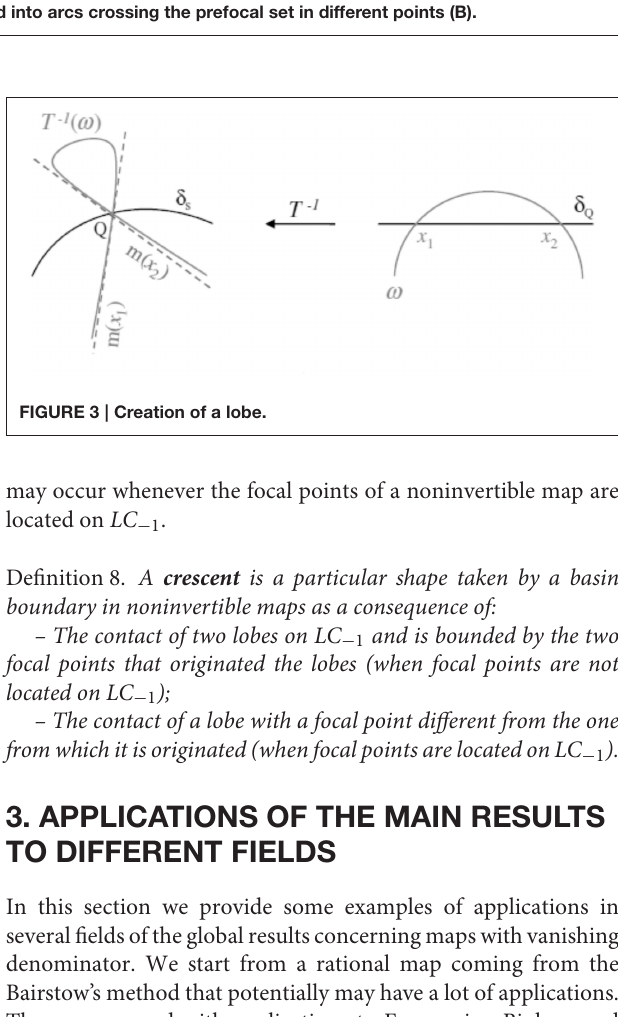
FIGURE 2 | Arcs crossing the focal point with different slopes (A) are mapped into arcs crossing the prefocal set in different points (B).